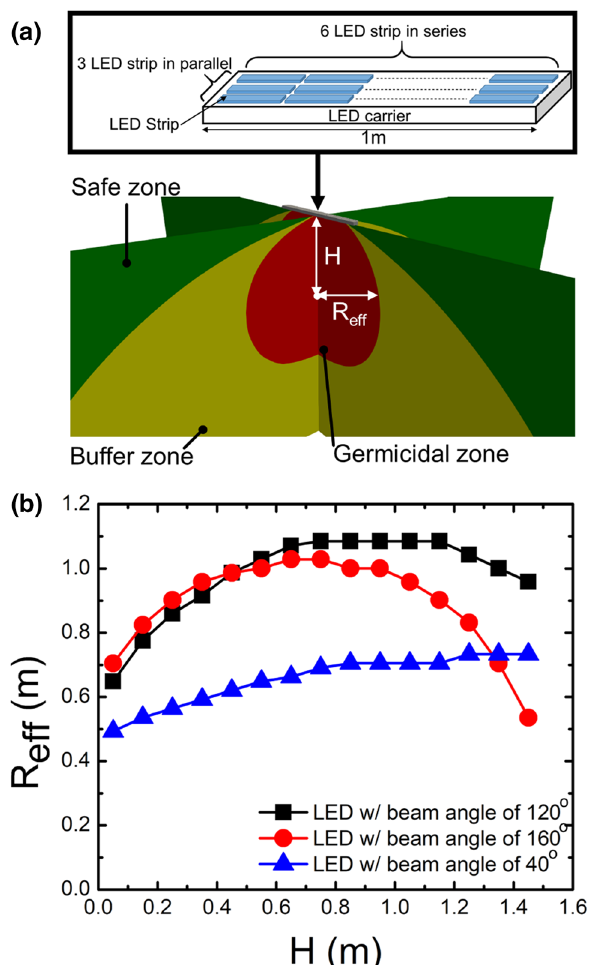
Figure 5. ( a ) The germicidal system designed with LED array composed of 3 × 6 LED strips is shown in the upper panel. The lower panel shows the vertical slice views of irradiance pattern emitted from the LED array in which the space can be divided into the safe zone in green (i.e., < 0.1μW/cm 2 ), the buffer zone in yellow, and the effective zone in red (i.e., > 18.7μW/cm 2 ). R eff is the radius for the effective germicidal region, for a particular distance H between the LED array and the detection point. ( b ) The correlation between H and R eff at the beam angle of 120°, 160°, and